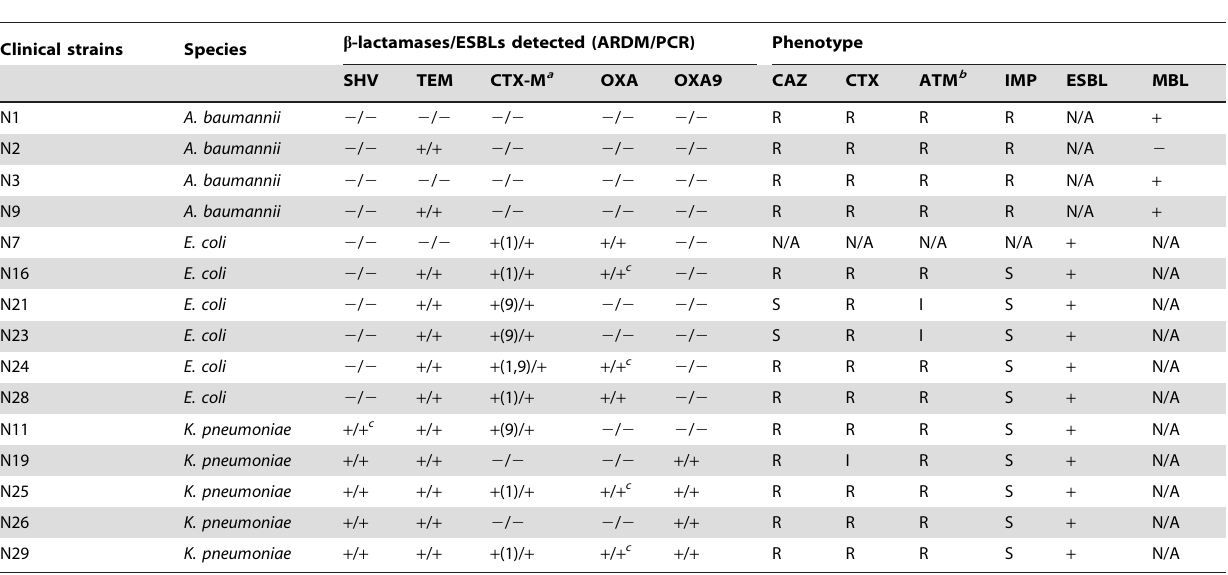
Table 4. ARDM v.1, PCR and phenotypic b -lactamase/ESBL profiles of the clinical and reference strains used in this study.